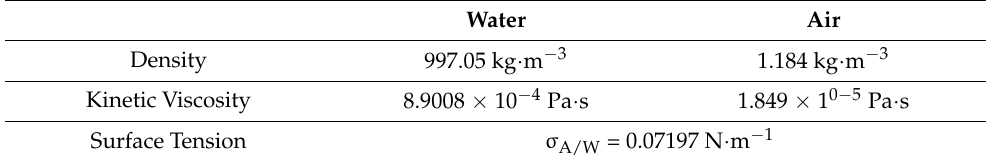
Table 1. Physical parameters of